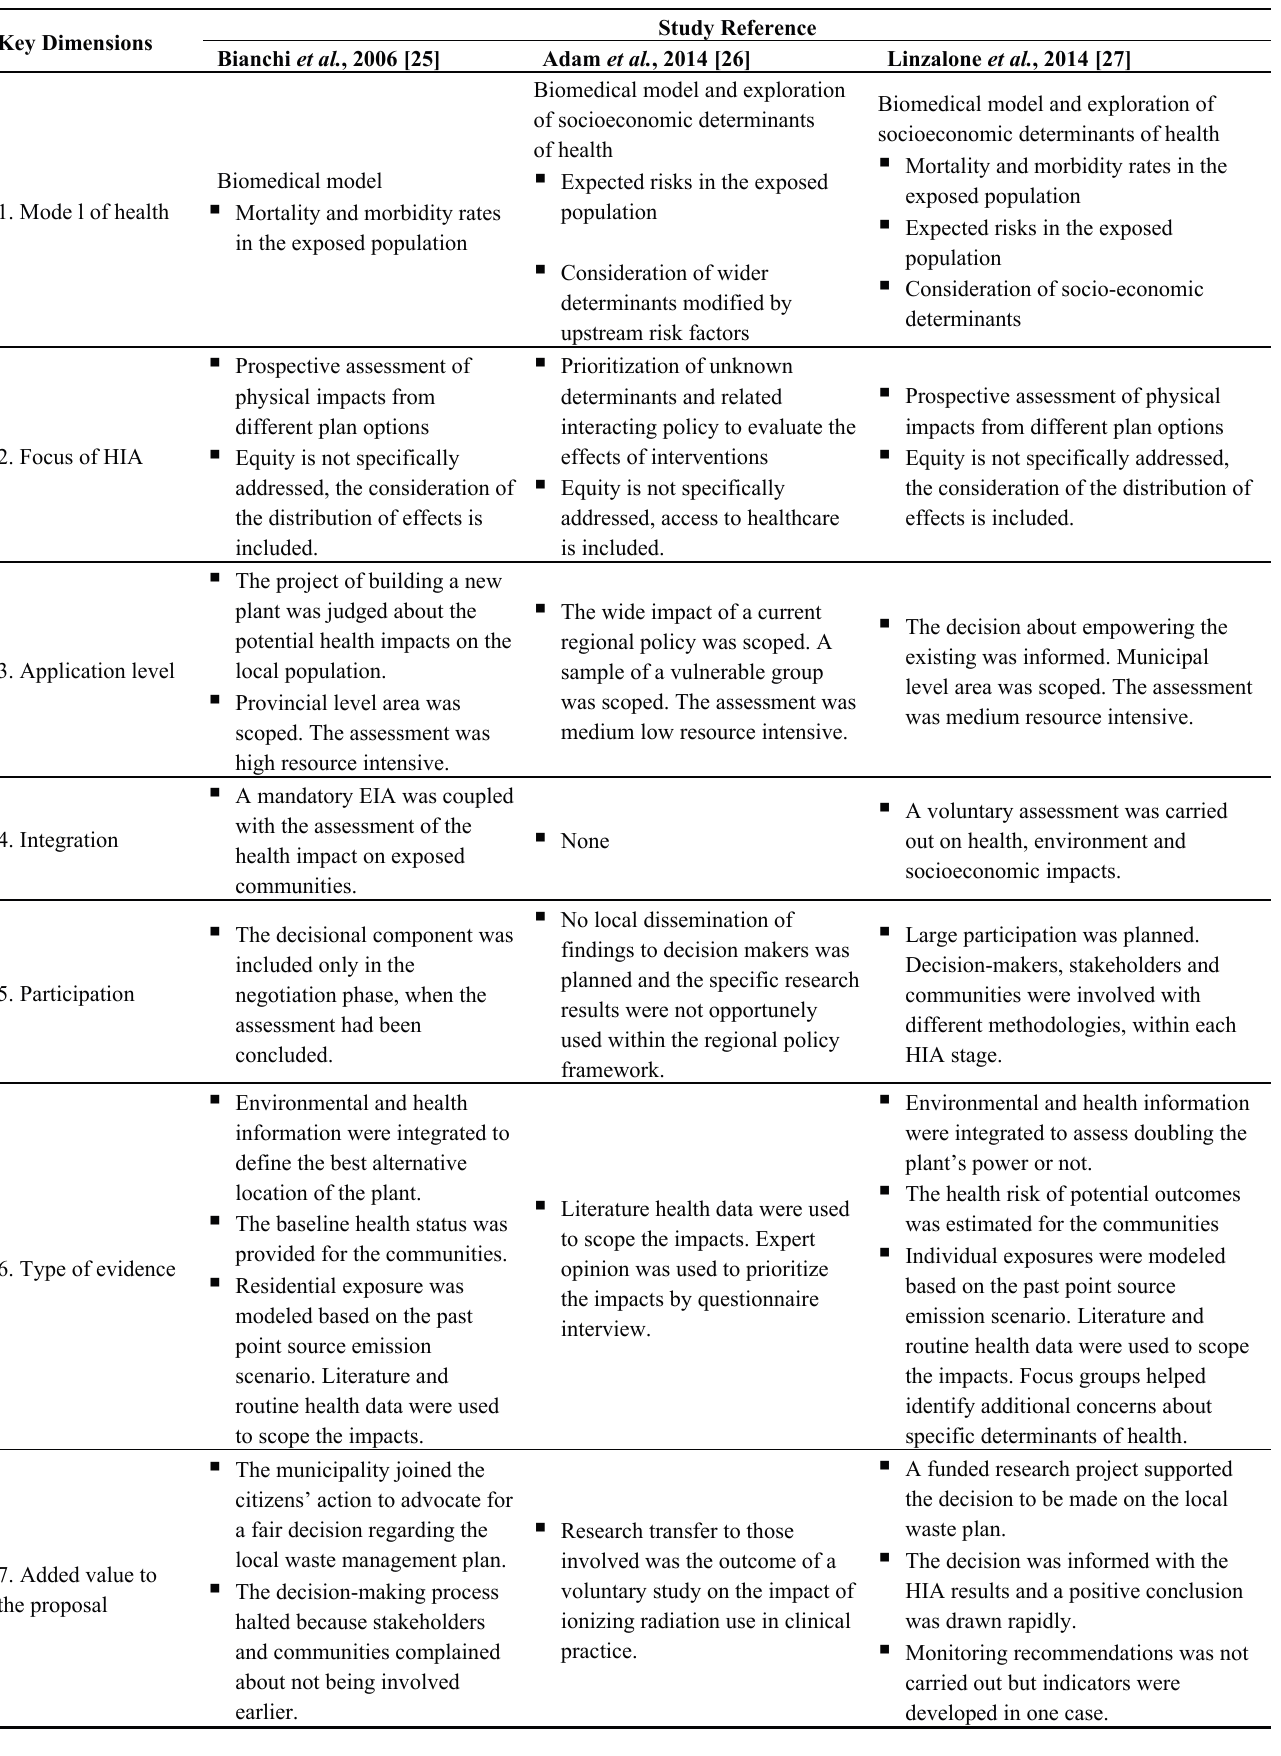
Table 2. Analytical framework: key aspects and questions addressed in HIA case